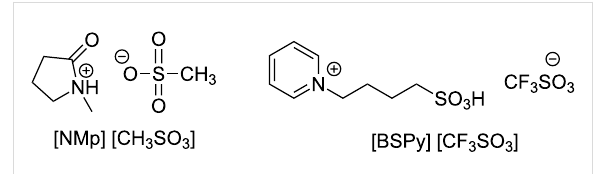
Figure 2: Representative examples of ionic liquids for biodiesel pro-